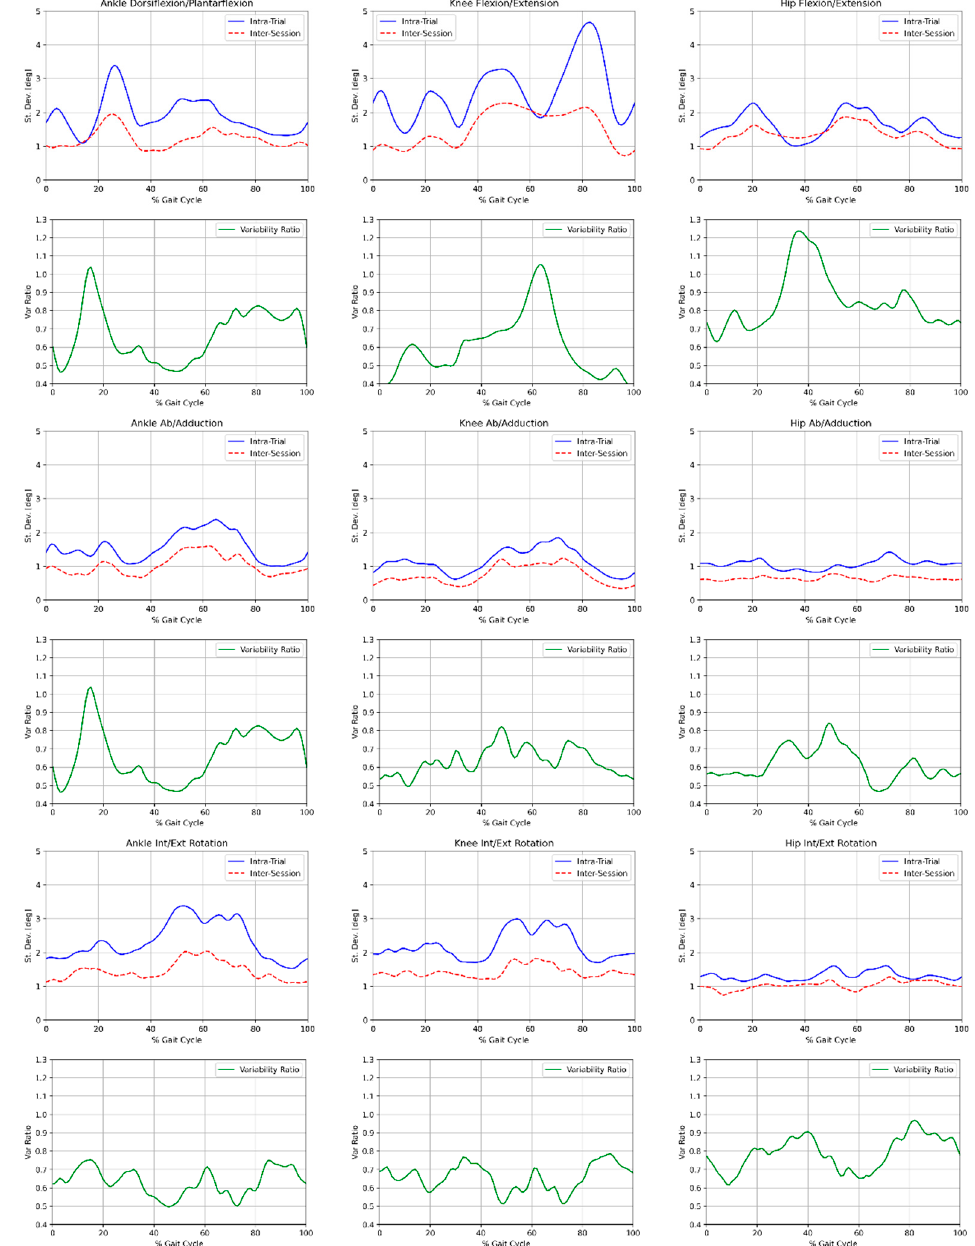
Figure 5. Averaged across 21 runners and three speeds. The intra-trial (solid blue line, n = 63) and inter-session (red dotted line, n = 3) across the entire time series.